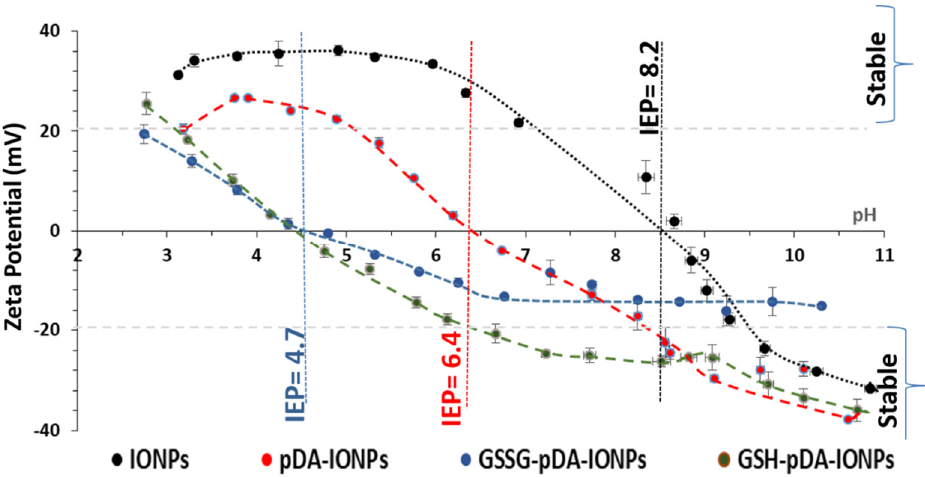
Figure 2. Zeta potential vs pH curves showing the isoelectric point of differently functionalized nanoparticles in 10 −2 M NaCl.